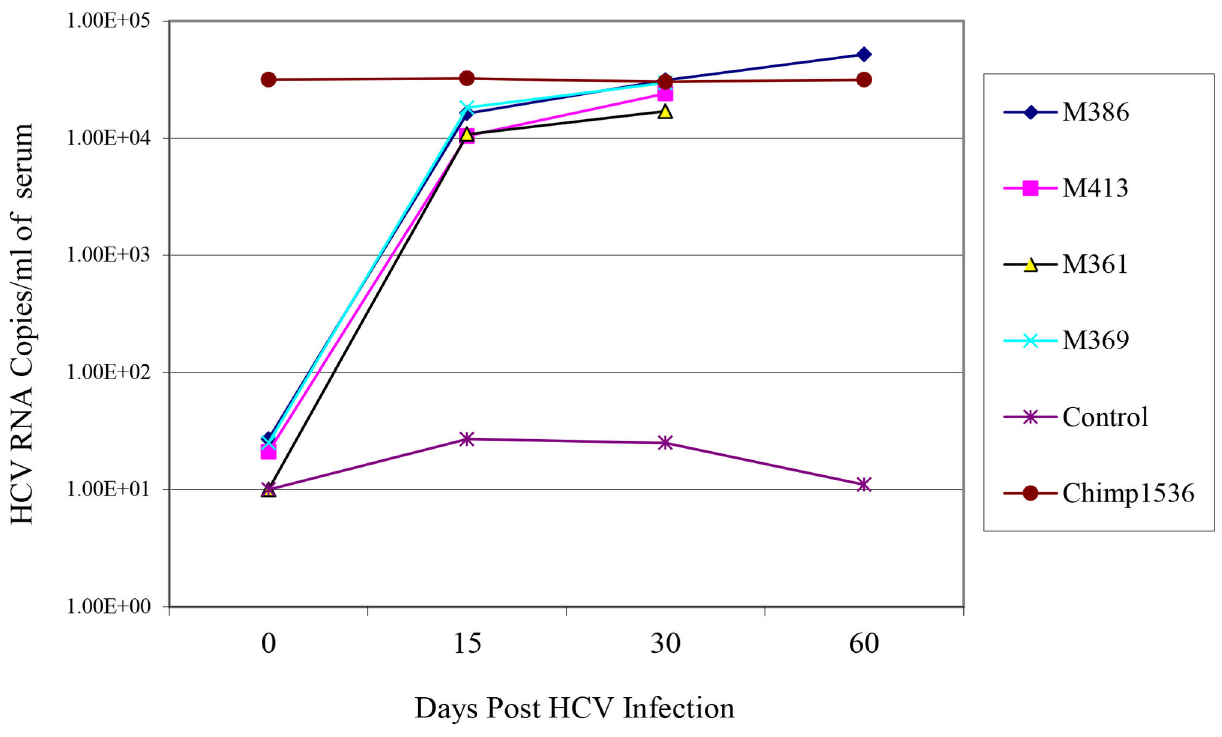
Figure 8. Long-term viral propagation of HCV genotype 1a in MUP-uPA/SCID/Bg chimeric mice. Several engrafted and HCV inoculated chimeric mice were monitored for 60 days post-inoculation for HCV replication and compared to mice that were not inoculated with HCV. Plasma from HCV-infected Chimpanzee was used as a positive control for HCV RNA copies in qRT-PCR